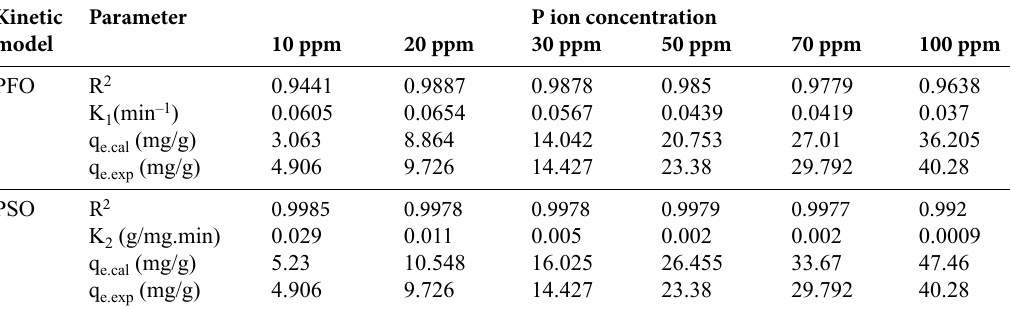
Table 4. Sorption kinetics of P ions using MnFe 2 O 4 nanoparticles Kinetic